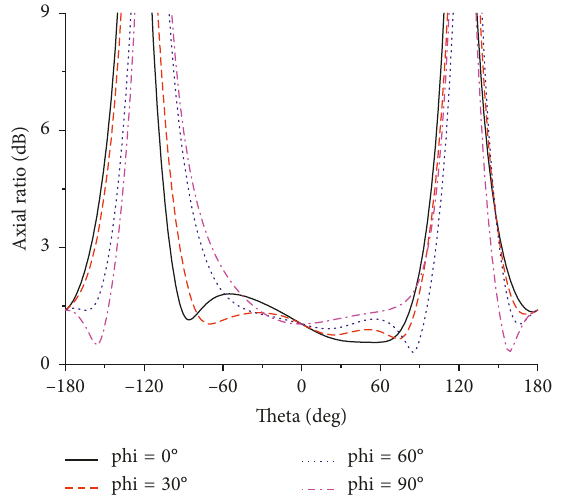
Figure 10: The designed antenna ARs in different planes at center frequency.